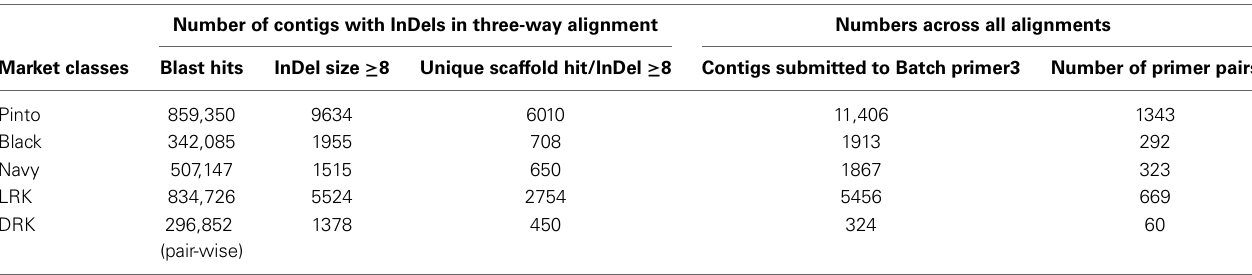
Table 5 | Filtering criteria for contigs used for primer